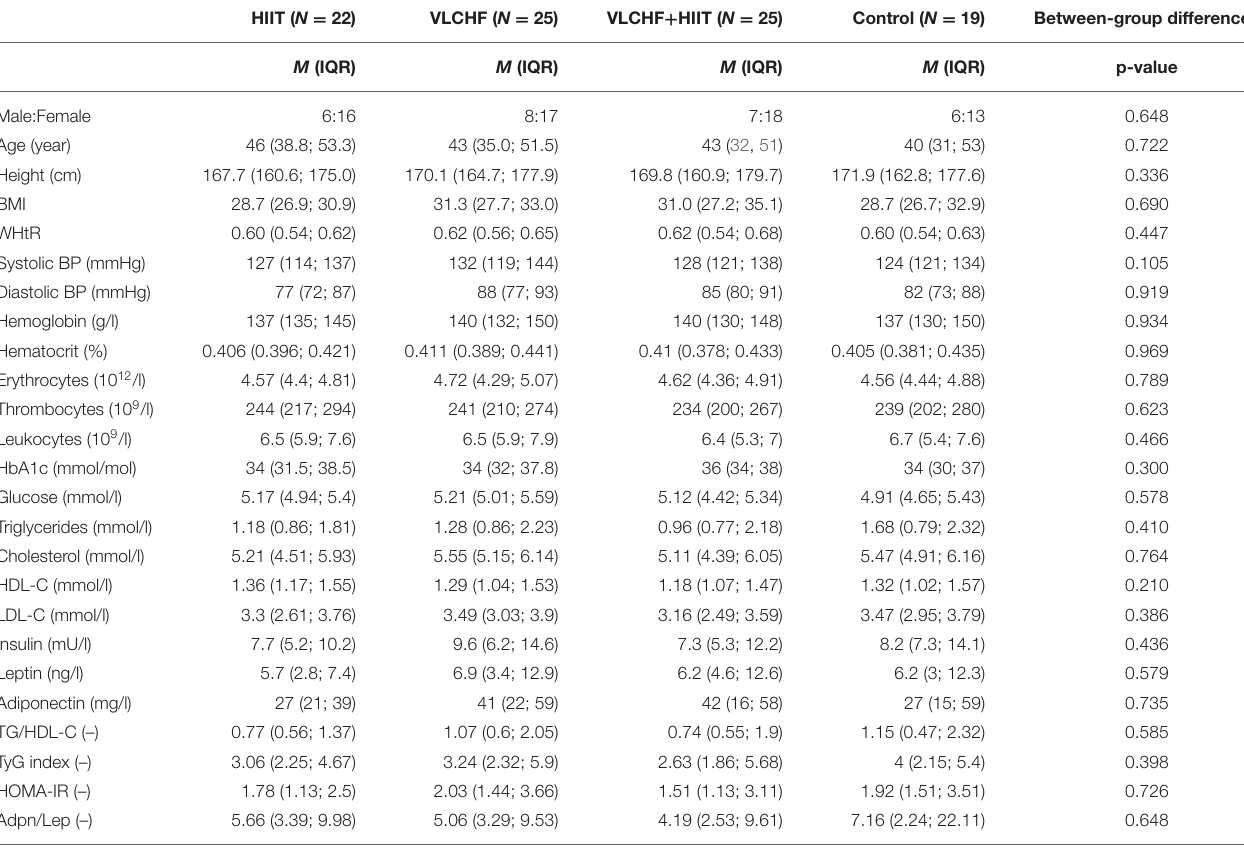
TABLE 1 | Baseline characteristics of study participants (all